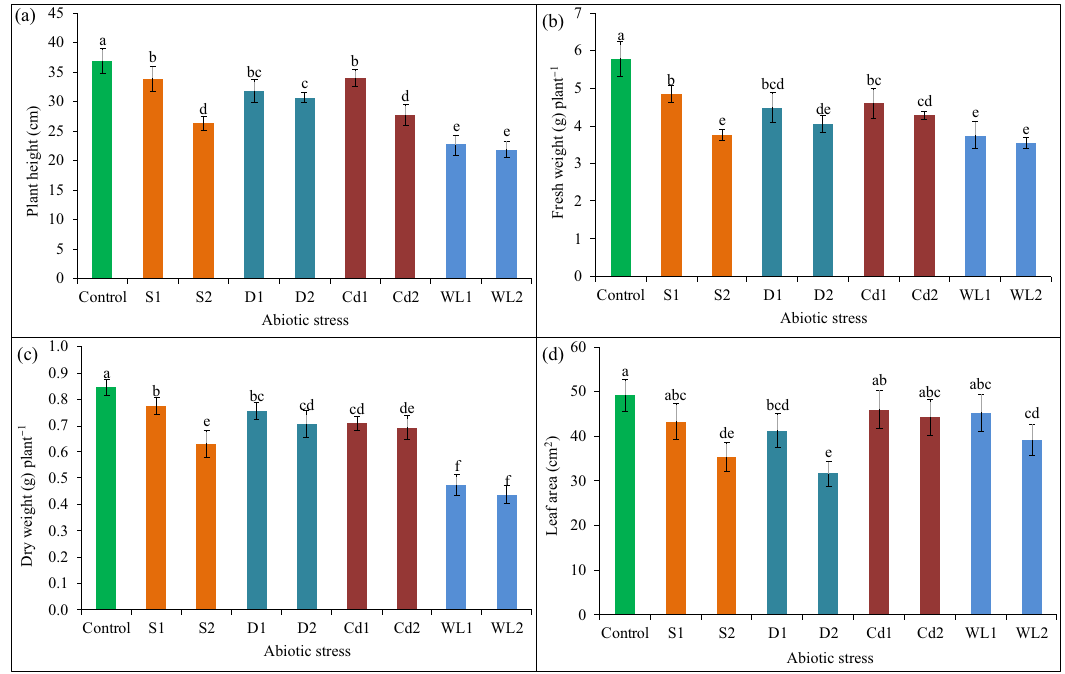
Figure 1: Plant height ( a ) , FW ( b ) , DW ( c ) , and leaf area ( d ) of C. olitorius plants a ff ected by di ff erent abiotic stresses. S 1 , S 2 , D 1 , D 2 , Cd 1 , Cd 2 , WL 1 , and WL 2 represent 200 mM of NaCl, 400 mM of NaCl, 10 days of water de fi cit, 15 days of water de fi cit, 2 mM of CdCl 2 , 4 mM of CdCl 2 , 5 days of waterlogging, and 15 days of waterlogging, respectively. Mean value (± SD ) was calculated from three replicates for each treatment. Values in a column with di ff erent letters are signi fi cantly di ff erent at p ≤ 0.05 applying LSD